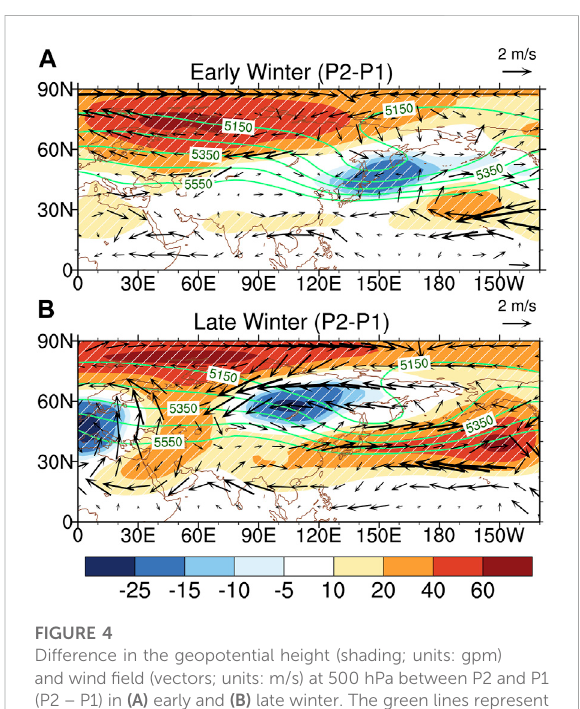
FIGURE 5 Difference in temperature (shading; units: K), geopotential height (contours; units: gpm) and wind fi eld (vectors; units: m/s) at 850 hPa between P2 and P1 in (A) early and (B) late winter. The white slanted lines represent p <